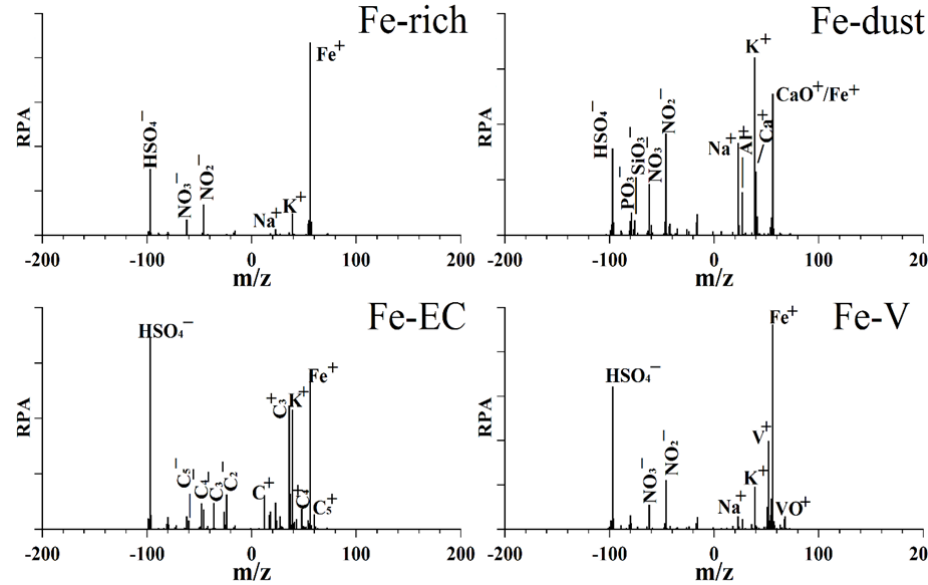
Figure 1. The average single-particle mass spectra of the four Fe-containing types. RPA refers to relative peak area.